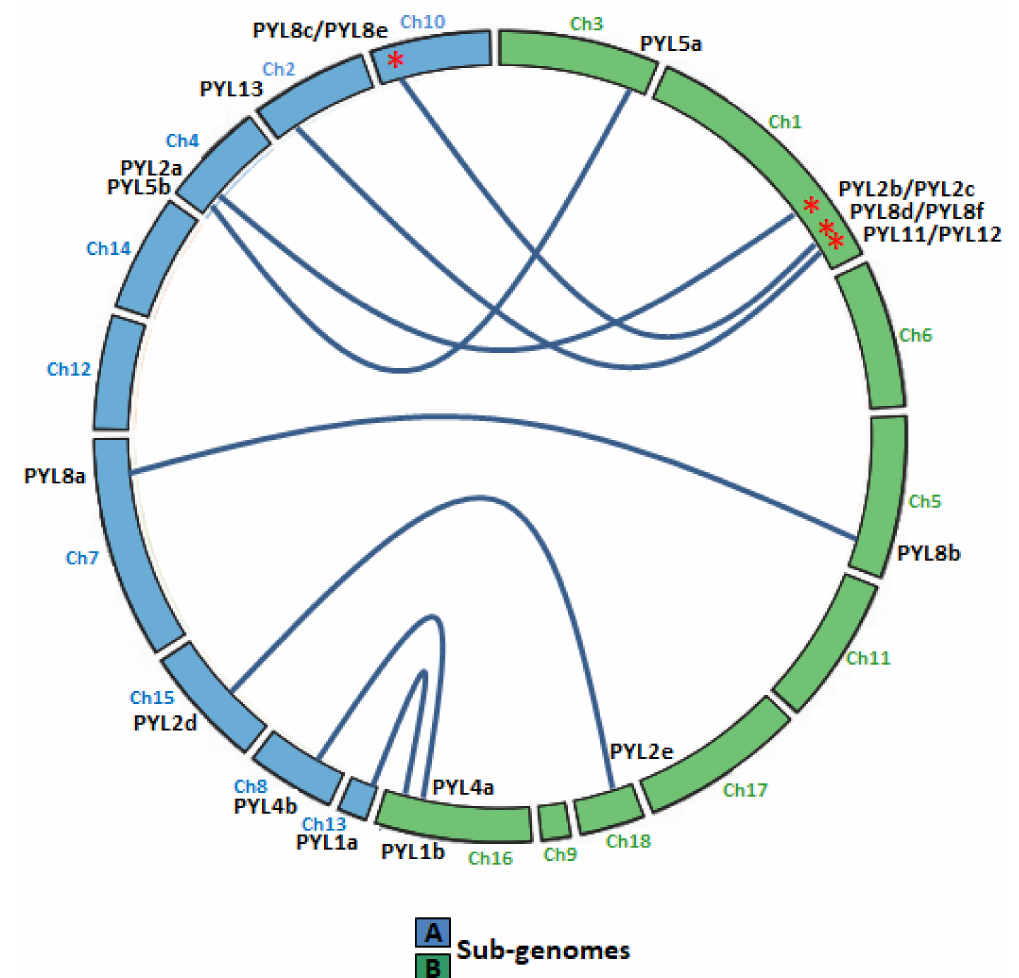
Figure 3. Collinear relationship between CqPYL genes. Homoeologous gene pairs in the A (blue chromosomes) and B (green chromosomes) sub-genomes are connected by blue lines. Red asterisks: paralogous CqPYL genes, proposed from a putative chromosome segmental duplication or pair of tandem duplication genes. Ch: chromosome